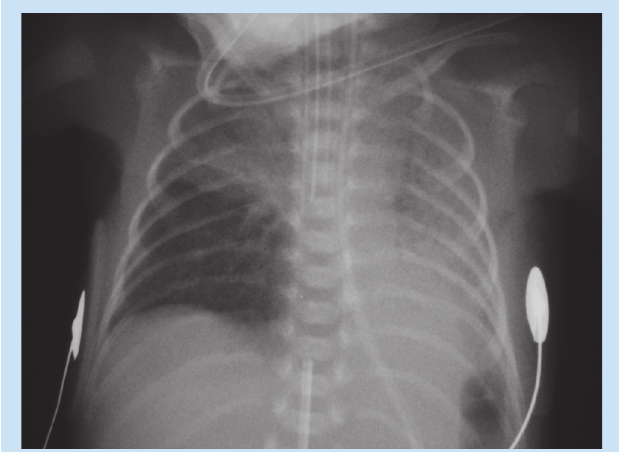
Fig. 9. Complications of lines and tubes. The endotracheal tube is low and has resulted in both right upper lobe and left lung collapse. The other tubes (NGT and UVC) are well